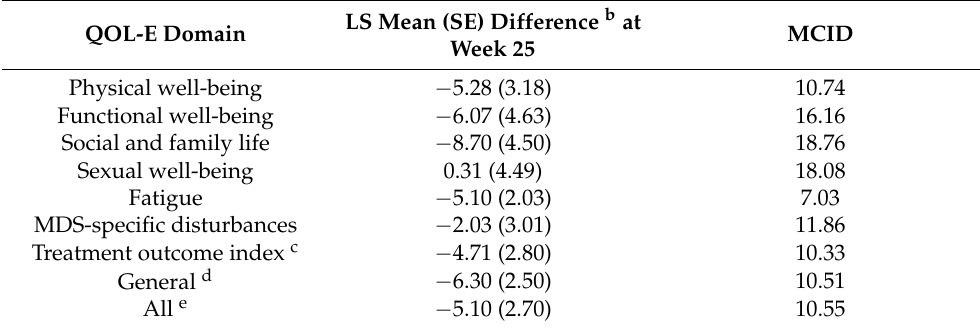
Table 5. LS mean difference in change in QOL-E domain scores from baseline to week 25 between luspatercept + BSC and placebo + BSC a .